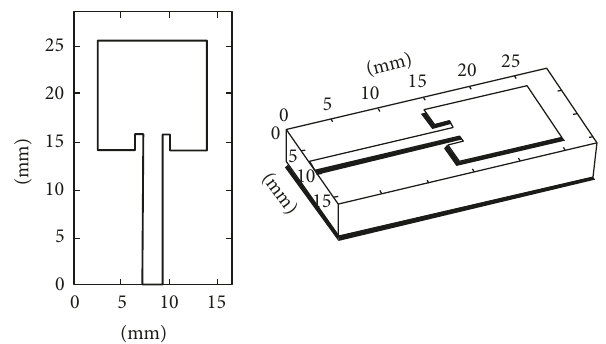
Figure 6: Microstrip antenna with inset (unscaled).